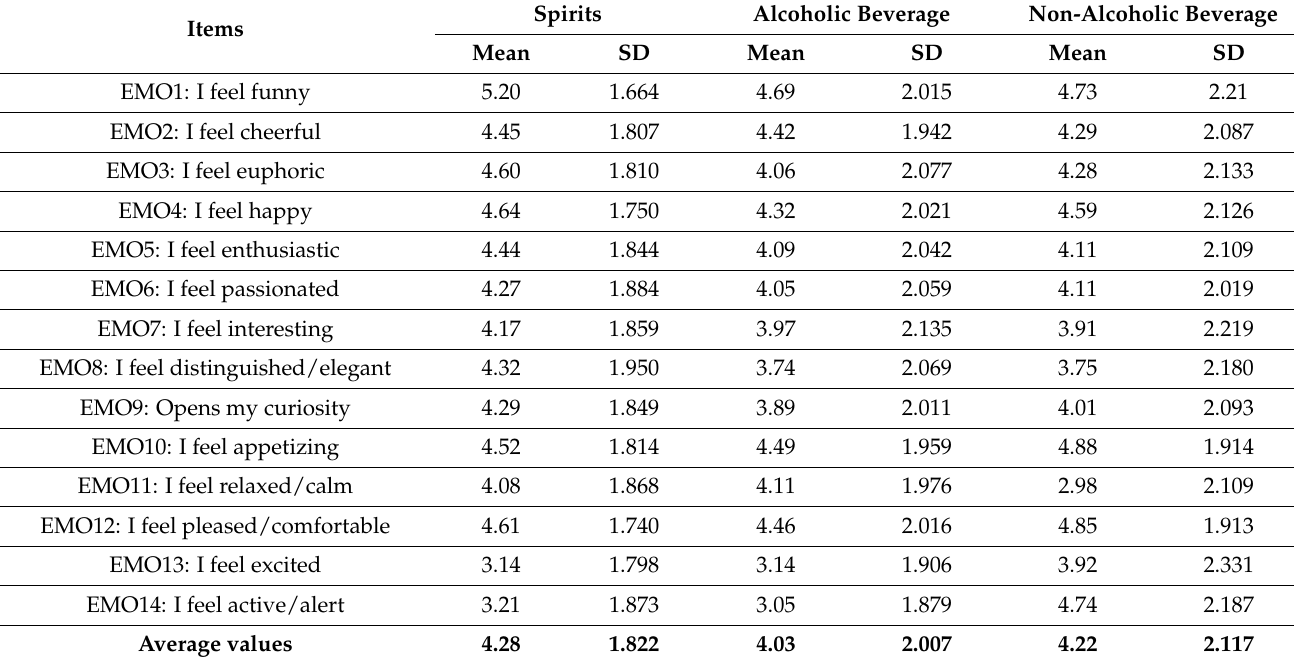
Table 2. Descriptive measures for positive